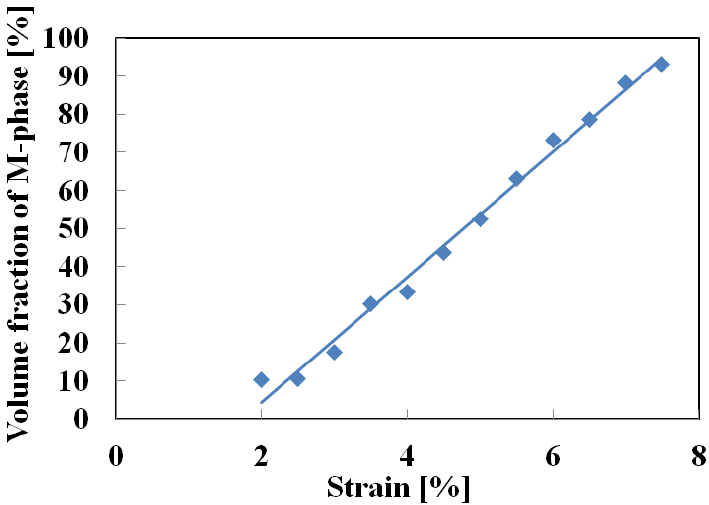
Figure 9. Relationship between volume fraction of M-phase and strain during creep